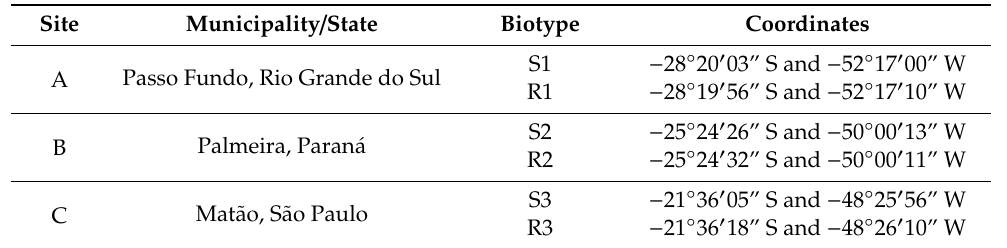
Table 1. Geographical locations of the Brazilian sites of seed collection of Conyza bonariensis biotypes. Site Municipality / State Biotype